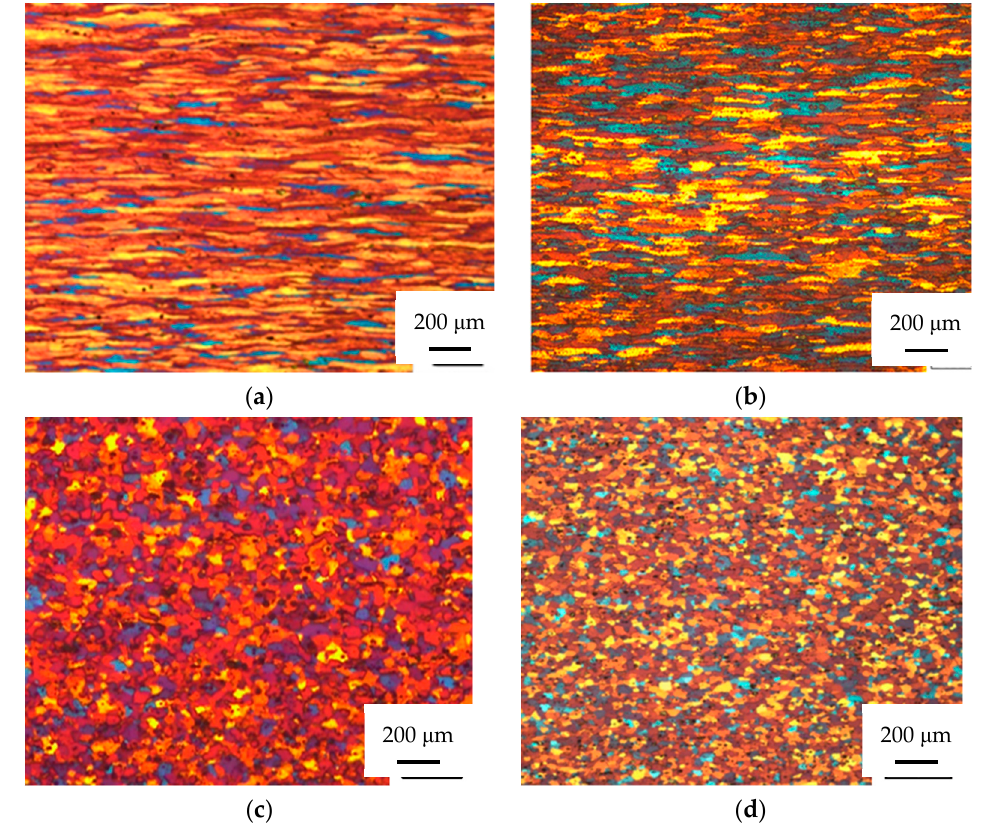
Figure 12. Grain structure after annealing of cold-rolled sheet ( a ) after cold rolling ( b ) after annealing at 250 °C, ( c ) after annealing at 350 °C, ( d ) after annealing at 500 °C.